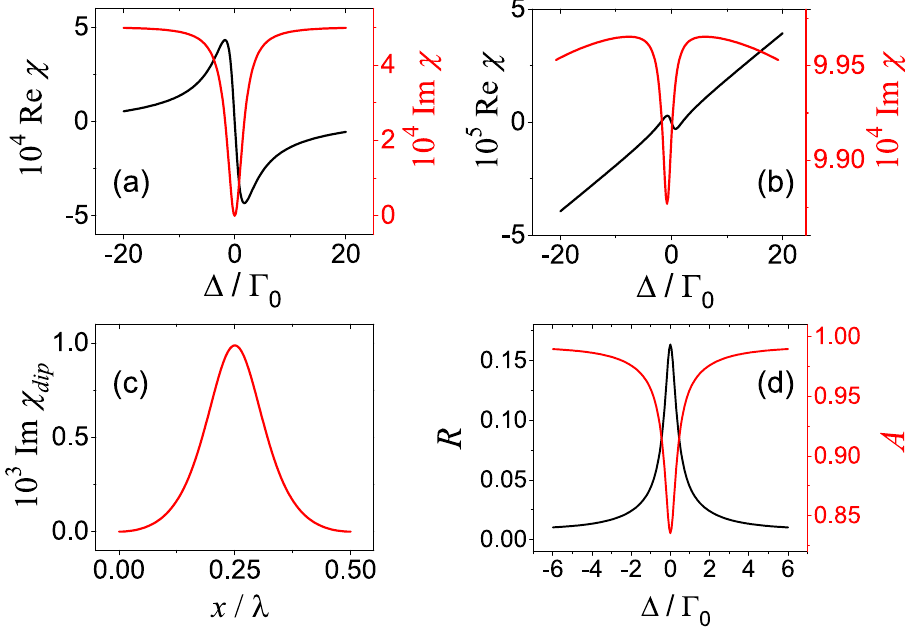
Figure 3. Susceptibility χ at antinodes ( a ) and nodes ( b ) for a m = η as the function of probe detuning Δ . ( c ) Imaginary part of the susceptibility for resonant probe field χ I within a spatial period. Such quantity can dip represent the modulation on the refractive index due to the relation of χ = + n 1 /2 . ( d ) The reflectivity (red line) and absorptivity (black line) plotted as function of Δ . Parameters are Γ = 500 Γ 0 , γ t = Γ 0 , λ c = 1.083 μ m, L = 5 mm, R m = 0.8, η = 0.0557, α = Γ 0 and a m = η